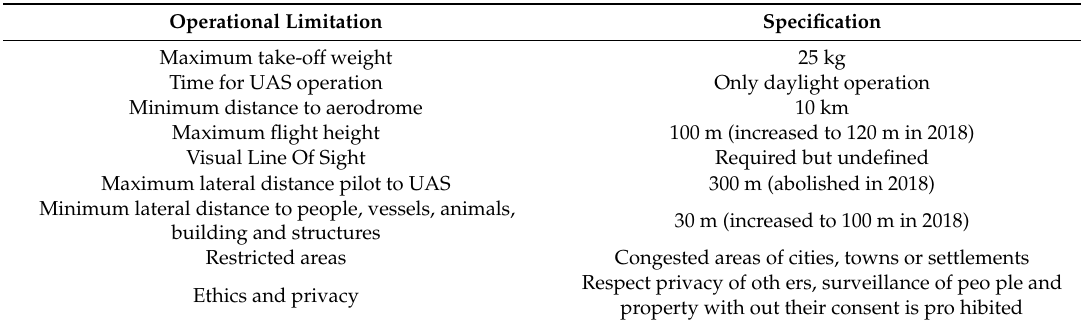
Table 2. Operational limitations for UAS flight missions in Rwanda according to Rwandan regulations